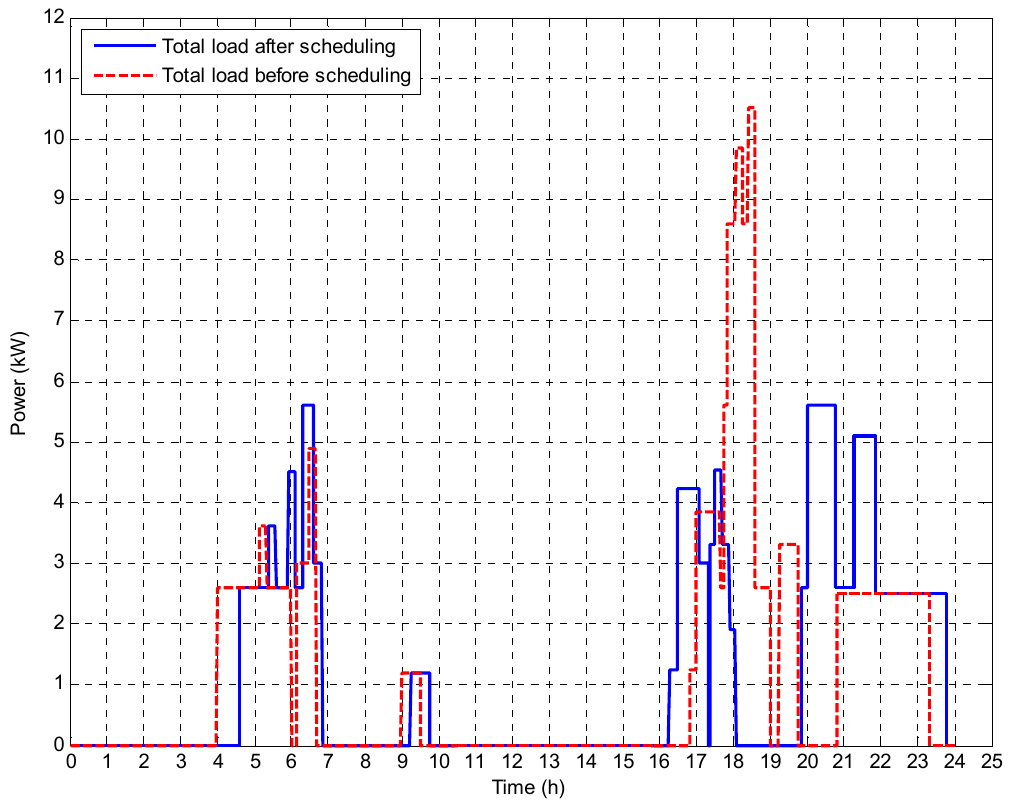
Figure 2. Total load before and after load scheduling.